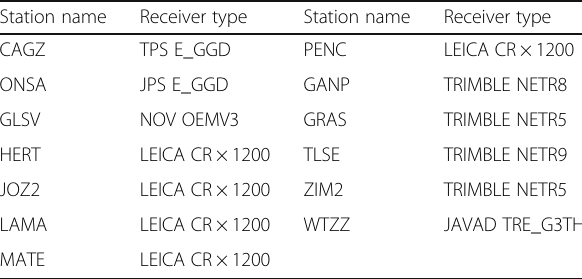
Table 1 Station name and the receiver type information